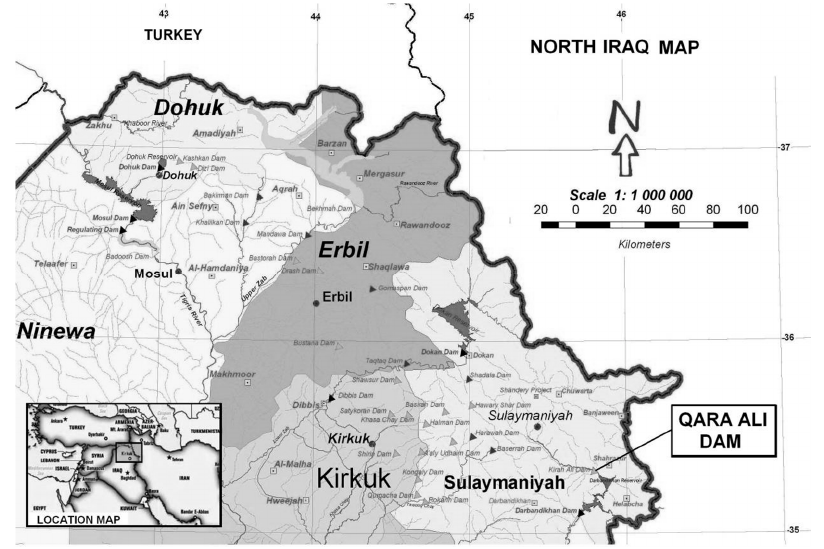
Figure 1. Location of the project area.